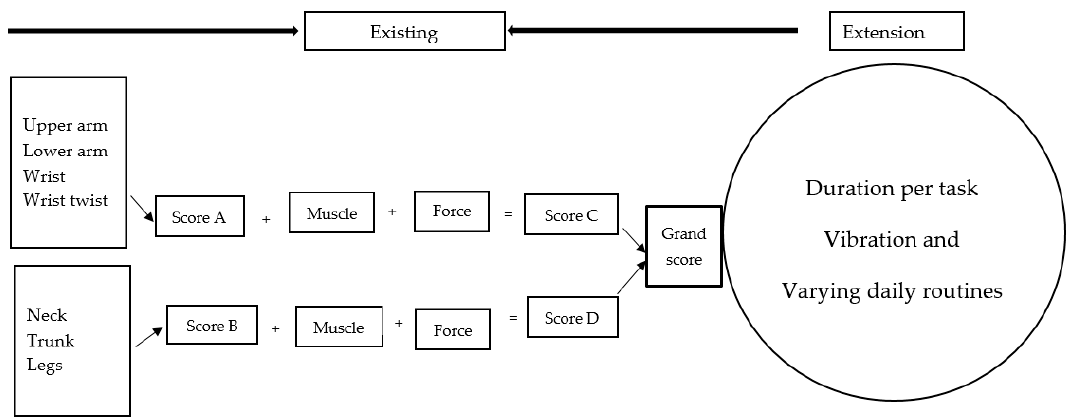
Figure 1. The RULA scoring sheet [10] extended to include duration, vibration and varying daily routines.